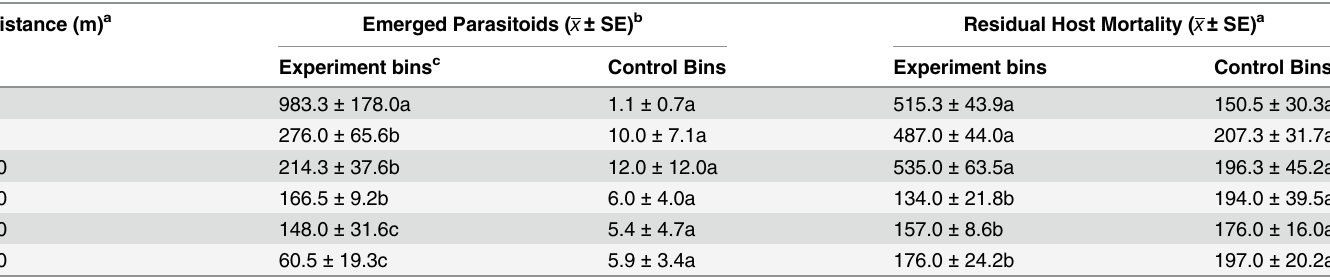
Table 2. Comparison of recovered parasitoid progeny and residual host mortality ( x ± SE) in treatment and control bins after releases of Spalangia cameroni at a 1:5 parasitoid:host ratio. Distance (m)